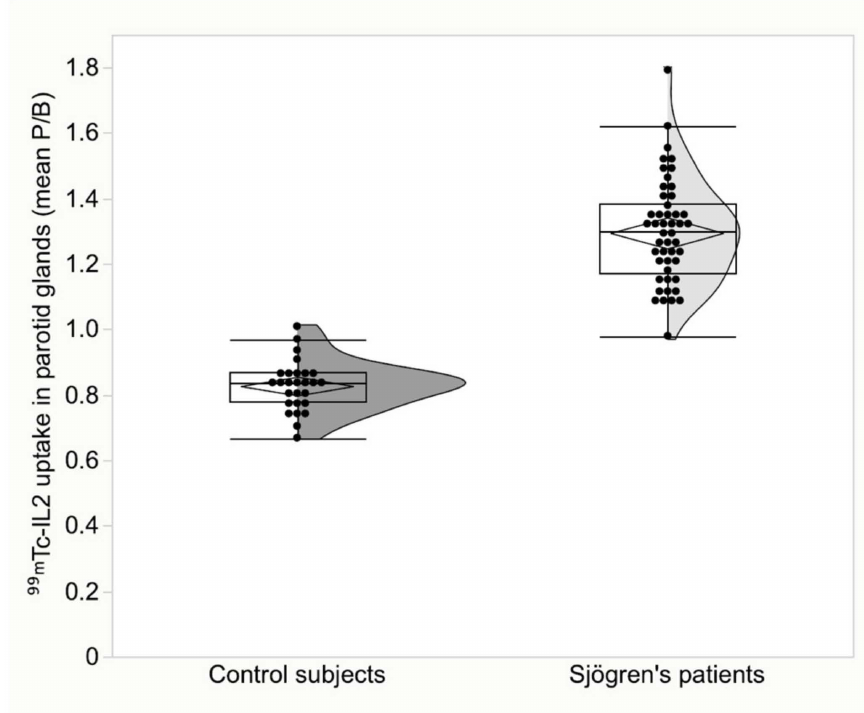
Figure 3. Parotid gland uptake of 99m Tc-IL2 in patients with Sjögren disease compared to control subjects ( p <